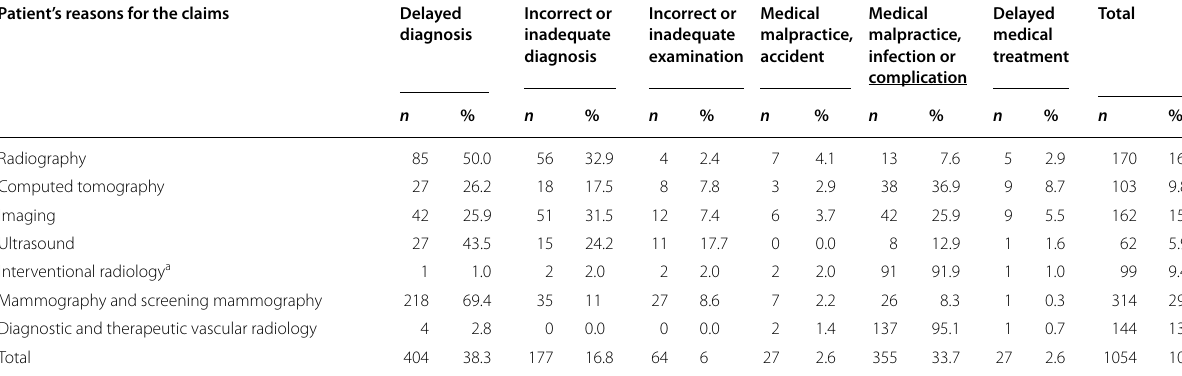
a Biliary intervention, catheter placement, genitourinary, pain management, contrast-enhanced and fluoroscopy examinations